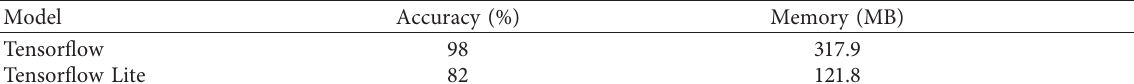
Table 5: Performance evaluation of two models.